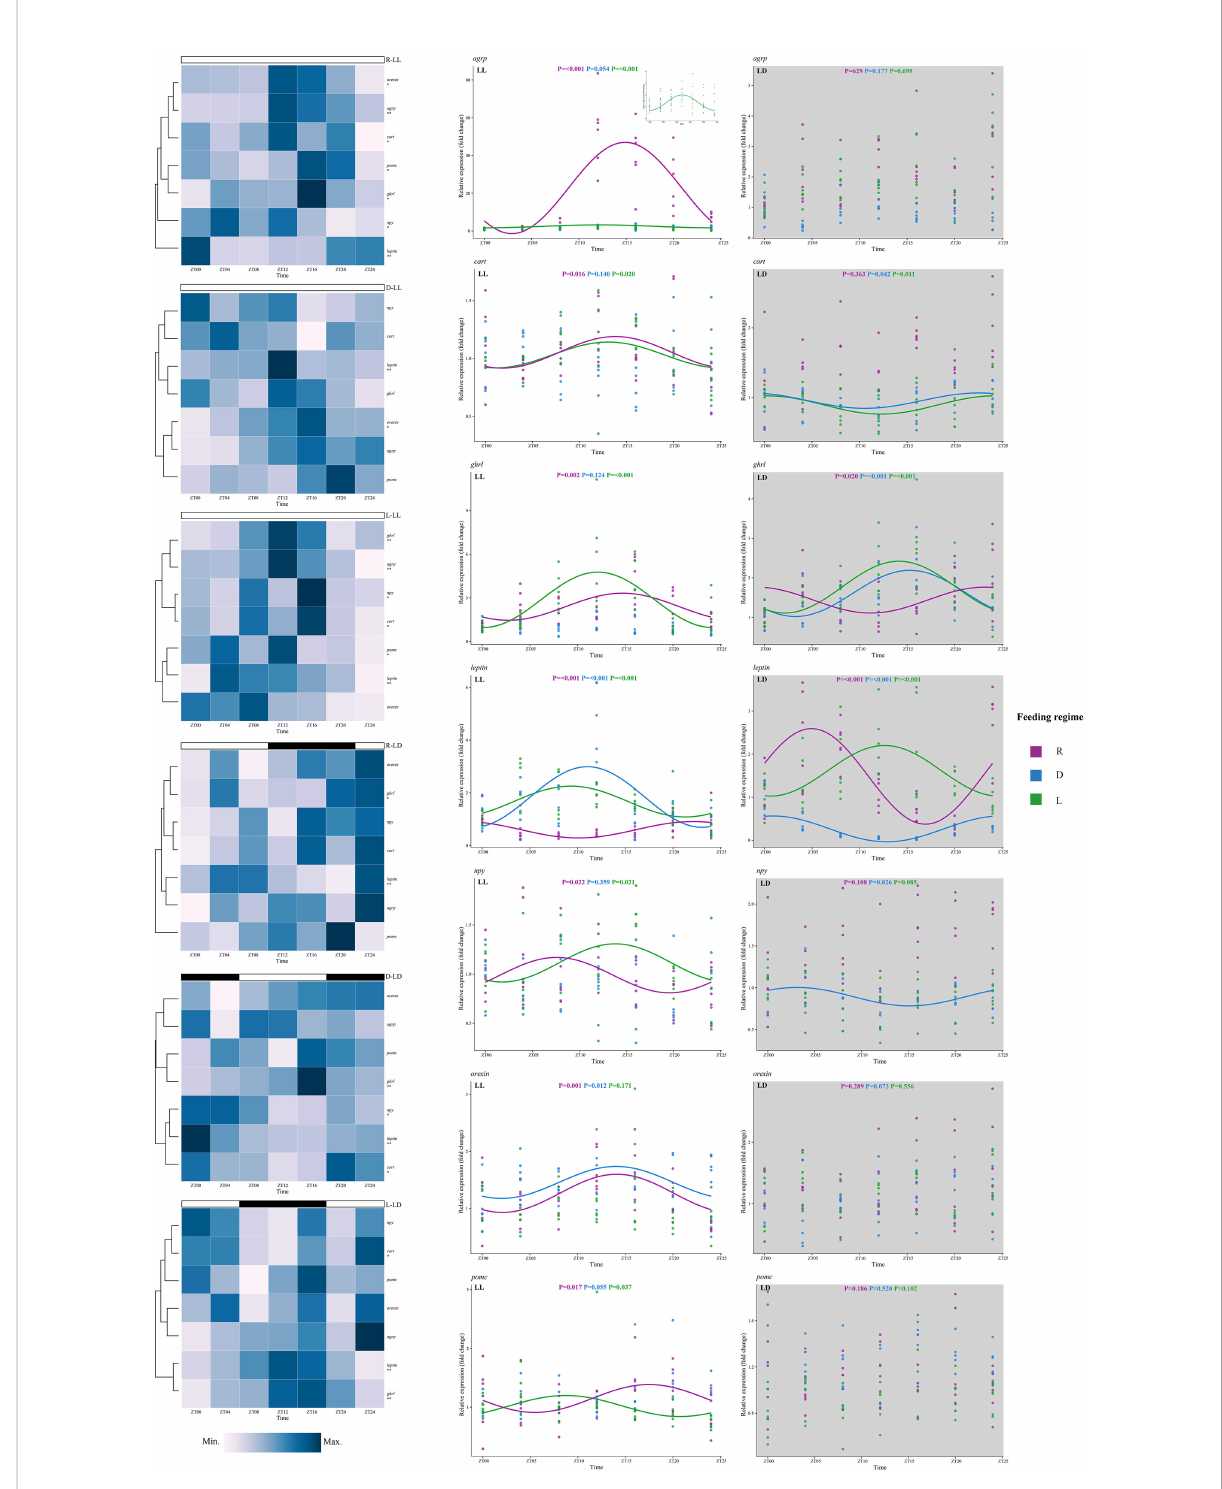
FIGURE 5 Expression of feeding-related genes of juvenile Oncorhynchus mykiss under different experimental treatment. Asterisks denote the presence of diurnal oscillations (*, P < 0.05; **, P < 0.01). The cosine curve denotes the presence of rhythmic oscillations ( P <